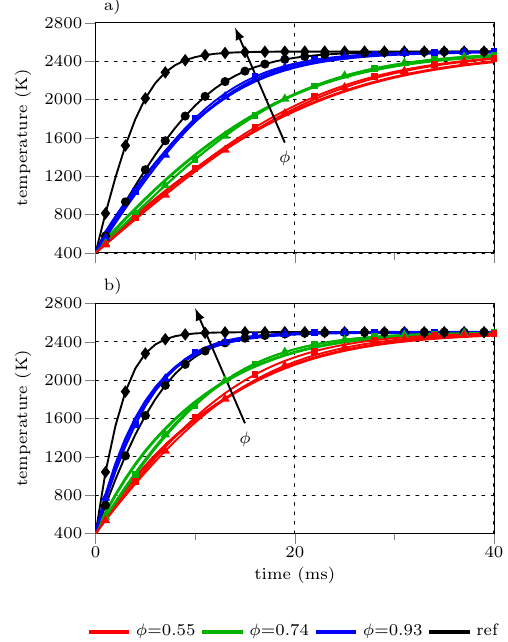
Figure 17. Comparison of resolved cluster mean temperatures ( ) and Lagrangian parcel tempera- tures using the radiative heat transfer correction and the Nusselt correlation ( ) and the Lévêque approach ( ) for relative velocities of 0.5 m/s ( a ) and 13 m/s ( b ). Size equivalent ( ) and surface and mass equivalent ( ) reference cases use the Whitaker heat transfer